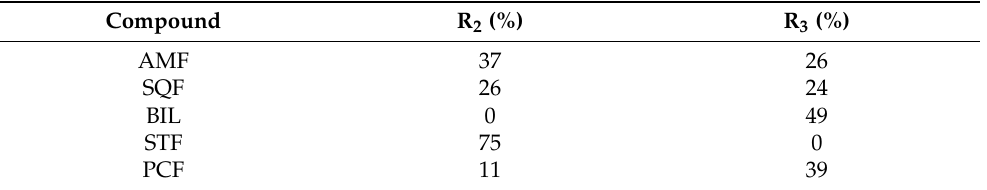
Figure 9. Amentoflavone (AMF) forming hydrogen bonds between R 2 and R 3 and the peptide backbone with hydrogen bond formation percentages by respective R-group (amino acid R-groups are stripped for clarity). Table 2. Percent trajectory for which R 2 and R 3 formed hydrogen bonds with the peptide backbone.